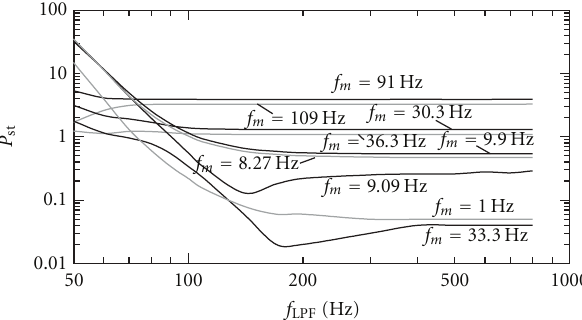
Figure 11: P st = f ( f LPF , f m , Δ f FM = 1Hz) characteristics for FM modulation with rectangular signals.